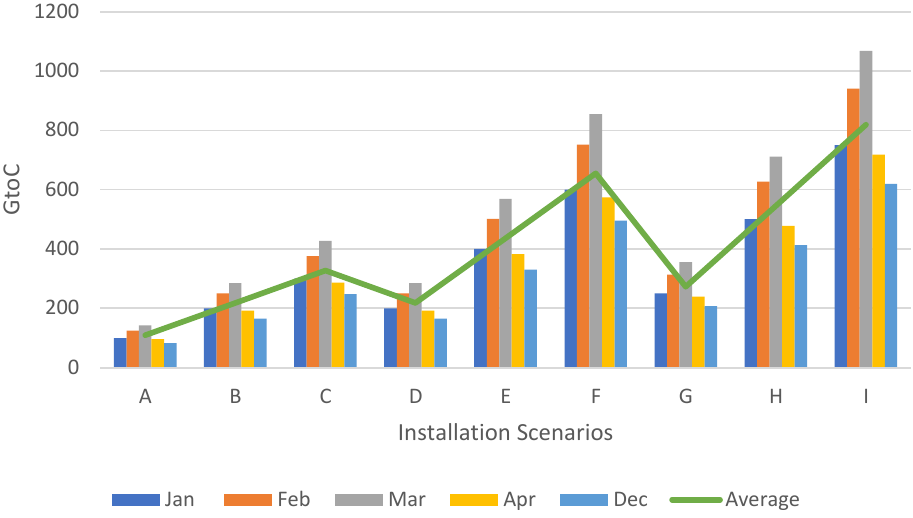
Figure 16. GtoC to Identify Energy Export Opportunities .